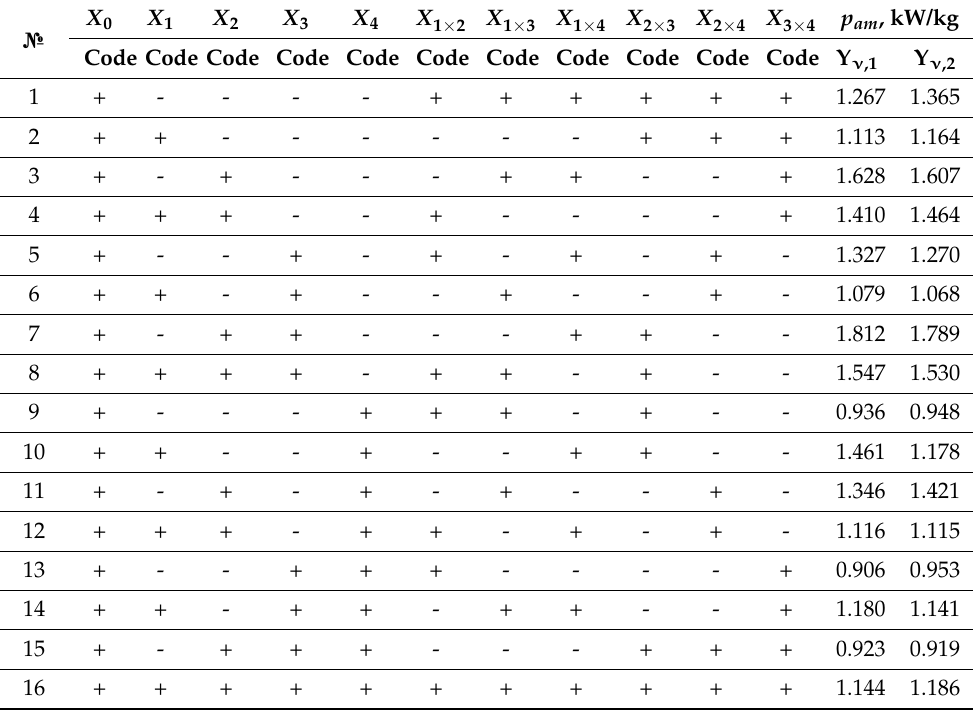
Table 2. The matrix of the full factorial